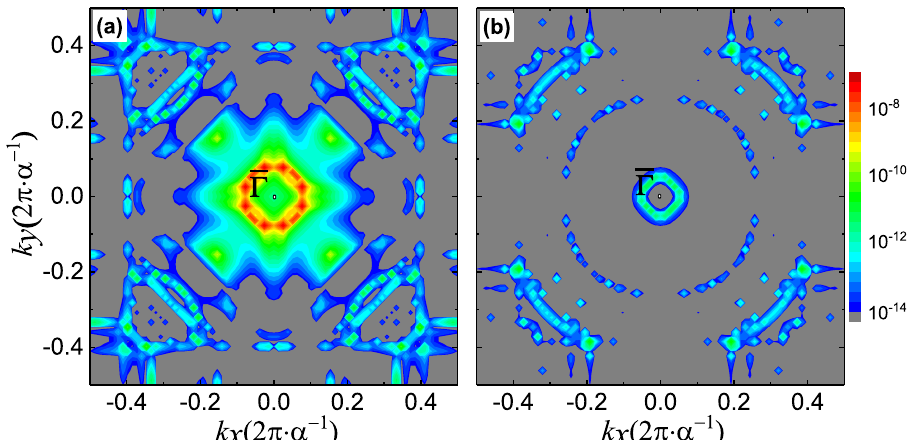
Fig. 4 k || -resolved transmission across FTJ-3. For polarization pointing right ( a ) and left ( b ) at − 0.12 eV below the Fermi level.